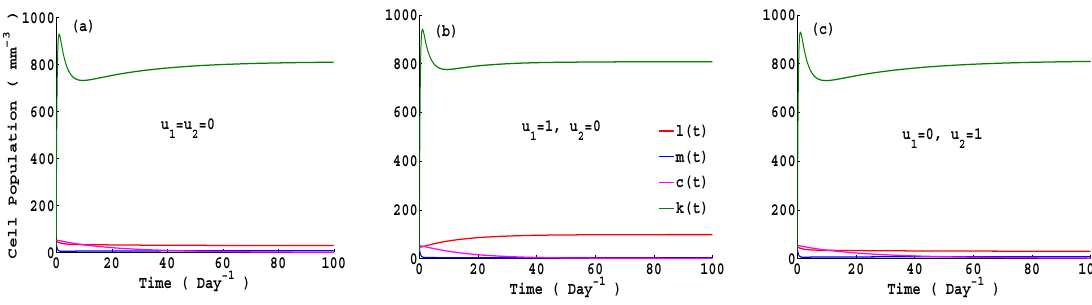
Fig. 3. Behaviors of different cell biological masses of the system (1) for perfect absence and presence of two drug efficacy parameters u 1 and u 2 , keeping other parameters at their standard values as in Table 1.